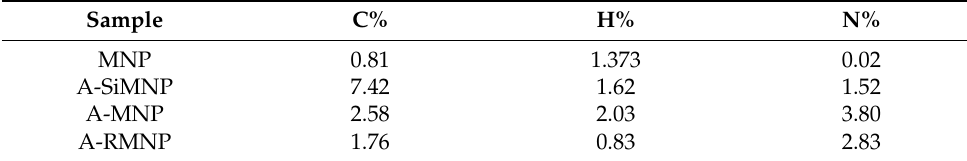
Table 1. CHN analysis of magnetite and alkylated